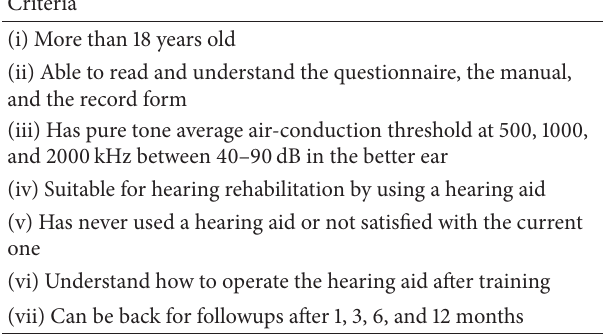
Table 4: Inclusion criteria.